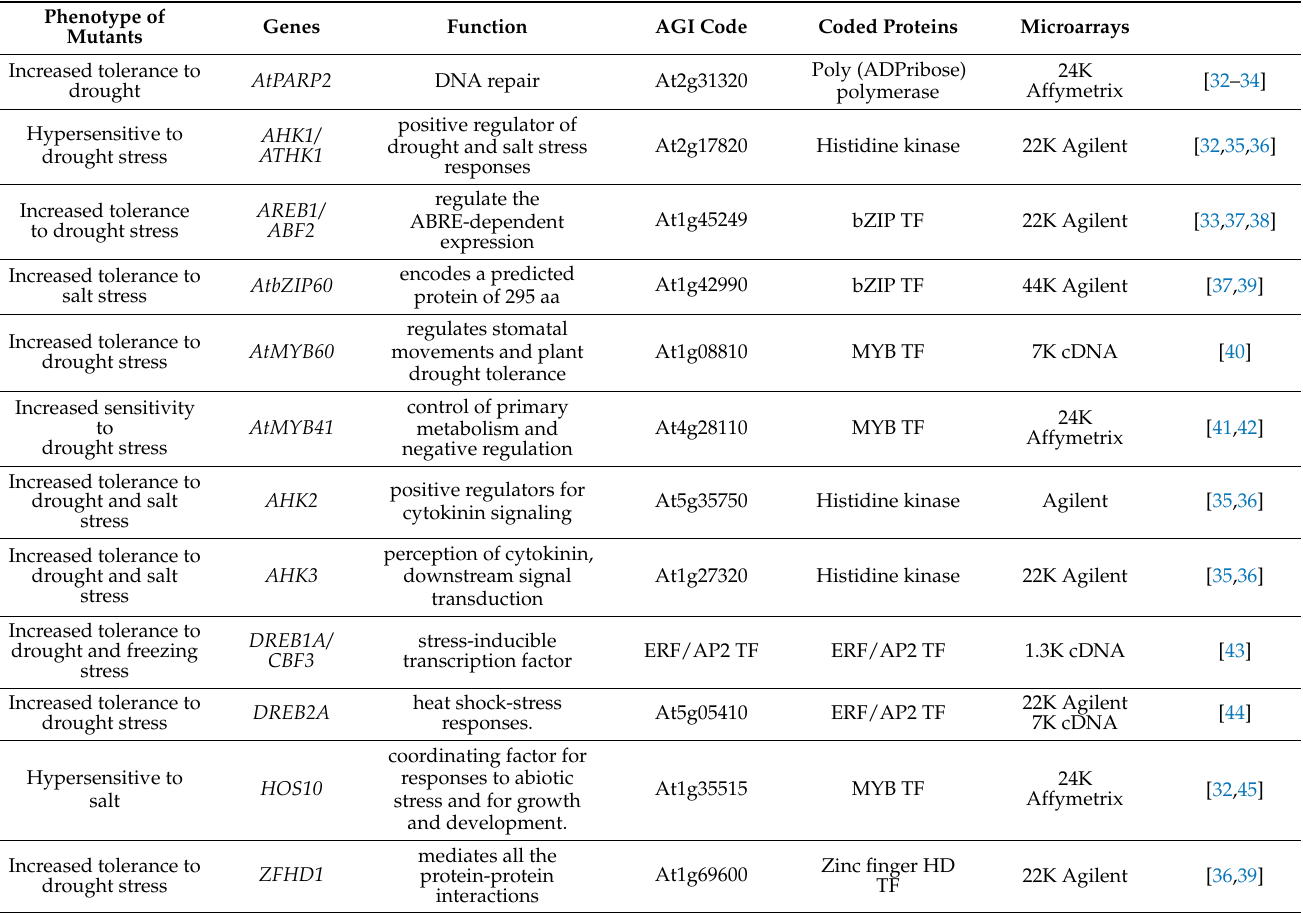
Table 2. Microarray analysis of genes involved in the drought, salinity and cold stress responses in